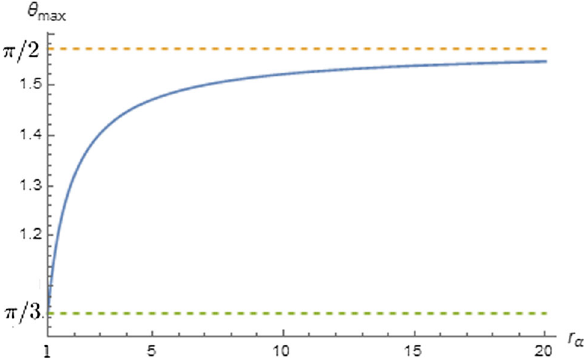
Fig. 3 The maximum angle to have a bounce as a function of the anisotropy velocity r α ∈ [ 1 , ∞ ) . The two limit values π π ( r α → ∞ ) are 2